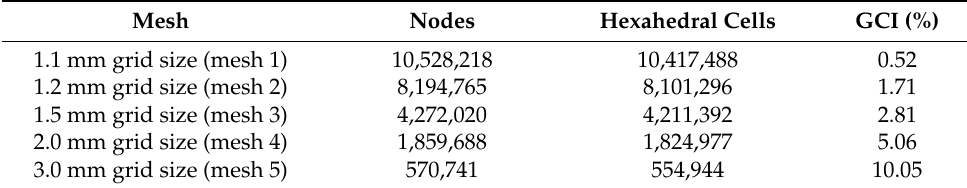
Figure 3. Structured meshes of the computational domain. Table 3. Cases of mesh